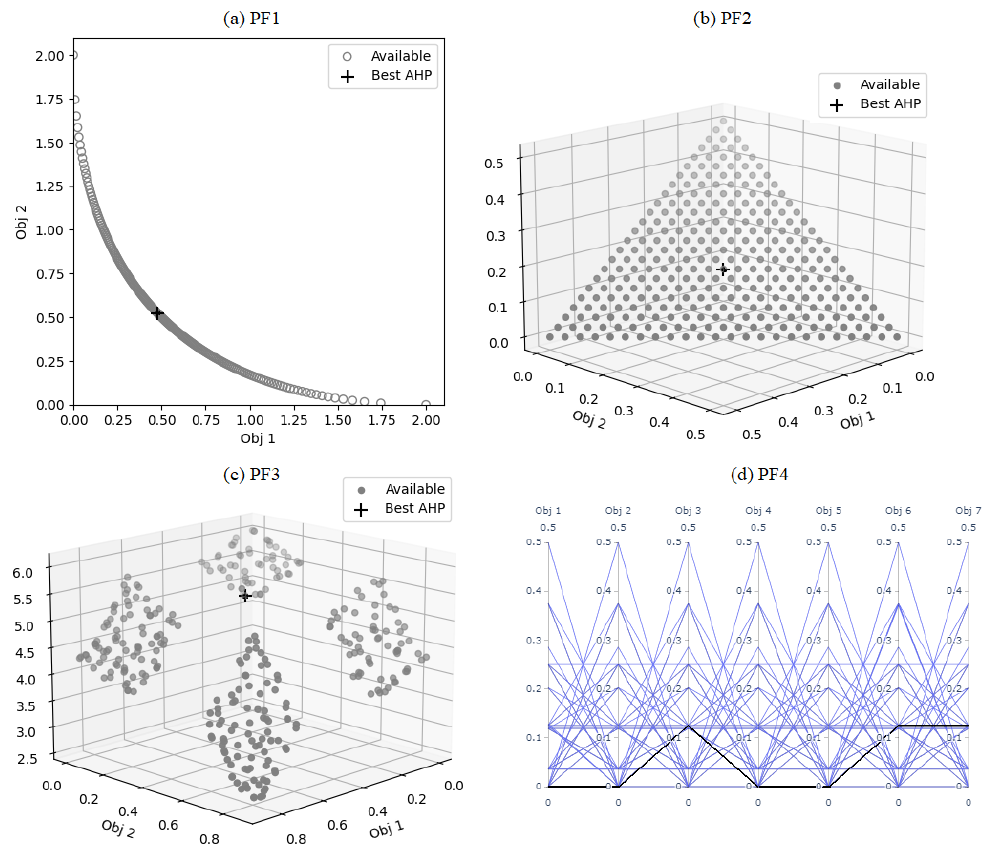
Figure 2. Pareto fronts (PF) representing the decision problems with 2 objectives in ( a )—GPD02, 3 objectives in ( b )—DTLZ1 and ( c )—DTLZ7, and 7 objectives in ( d